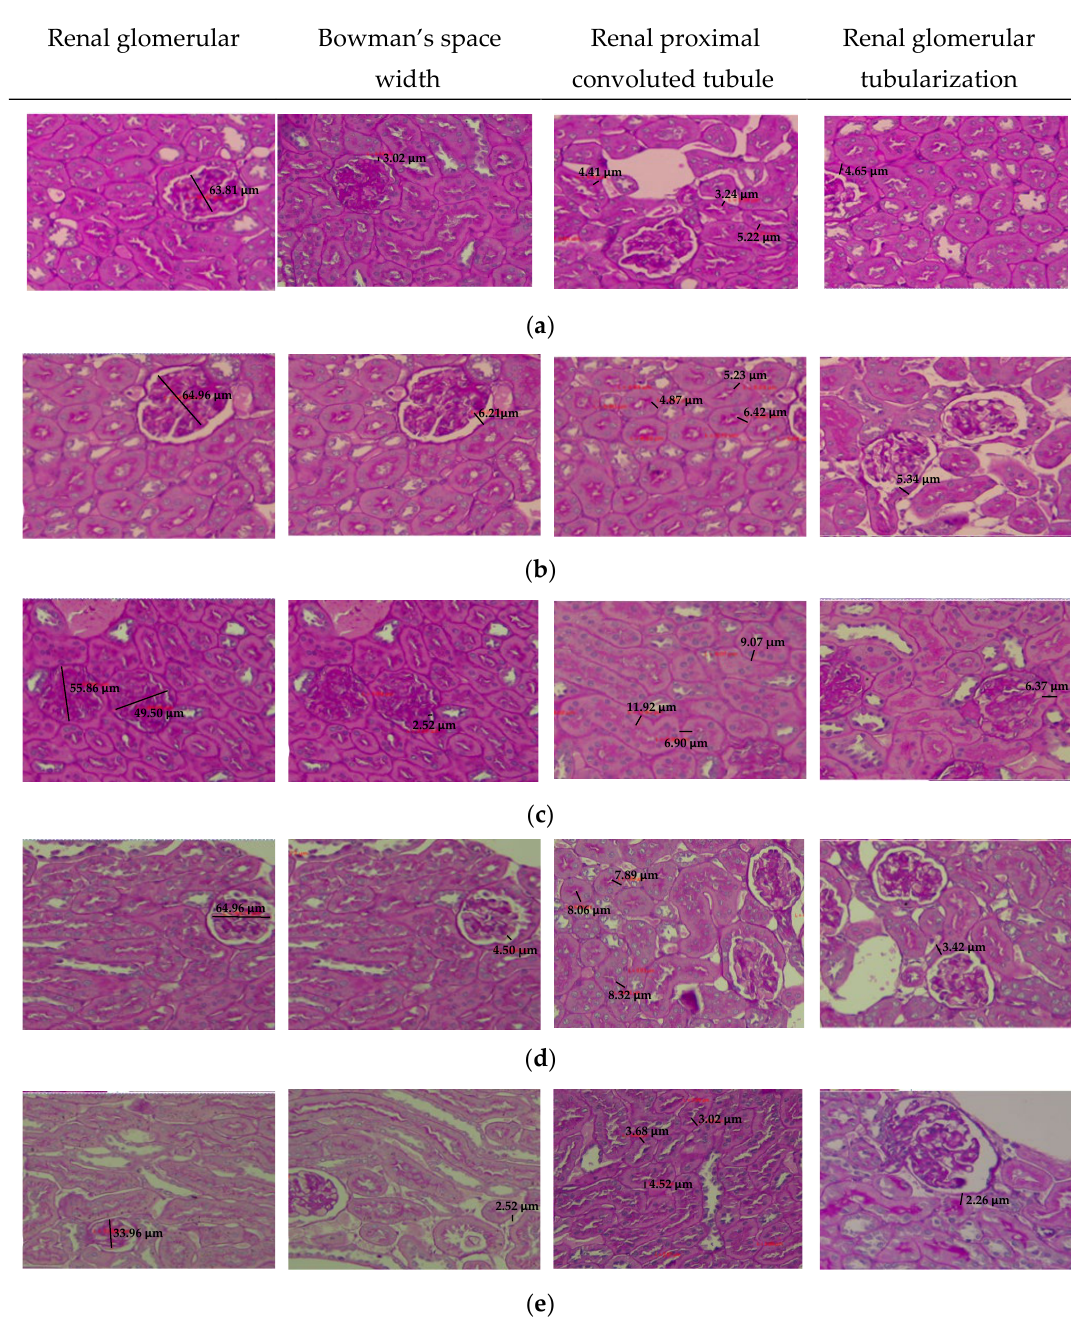
Figure 4. Histopathology profiles: the renal glomerular diameters, the Bowman’s space width, the renal proximal convoluted tubule and the renal glomerular tubularization of the left kidney. All figures were prepared by Hematoxylin and Eosin (H&E) staining at 400 × magnification in each group of: ( a ). Negative control; ( b ). Positive control; ( c ). Low-dose ethanol extract of soursop leaf (LD-SLEE) group 150 mg/kg BW; ( d ). Medium-dose ethanol extract of soursop leaf (MD-SLEE) group 300 mg/kg BW; ( e ). High-dose ethanol extract of soursop leaf (HD-SLEE) group 600 mg/kg